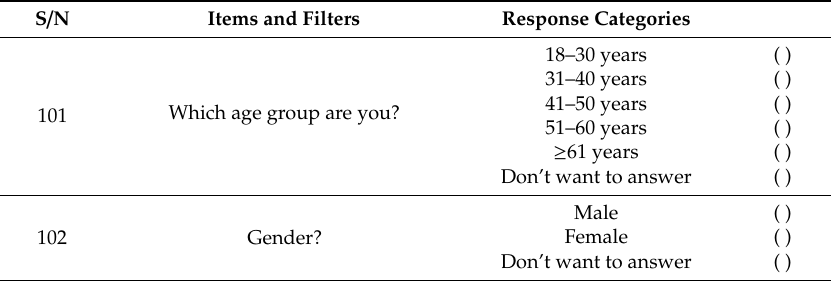
√ ) the appropriate